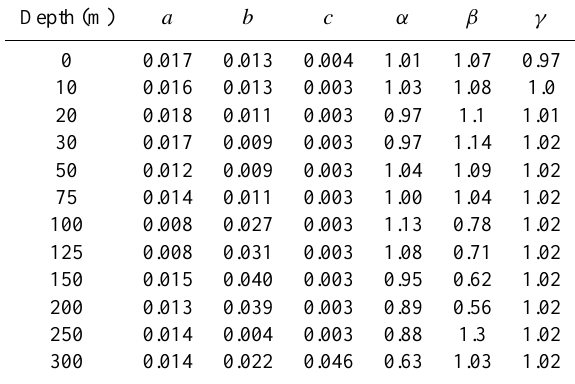
Figure 7, The best fitting of the mean correlation models to the averaged correlations in (a) the longitudinal, (b) latitudinal and (c) temporal direction. The correlation model is fitted to correlations of all the spatial bins.